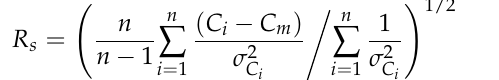
Figure 4. Repeatability of the baseline solutions in east, north, and up directions for SD-Float and SD-Fix solutions.